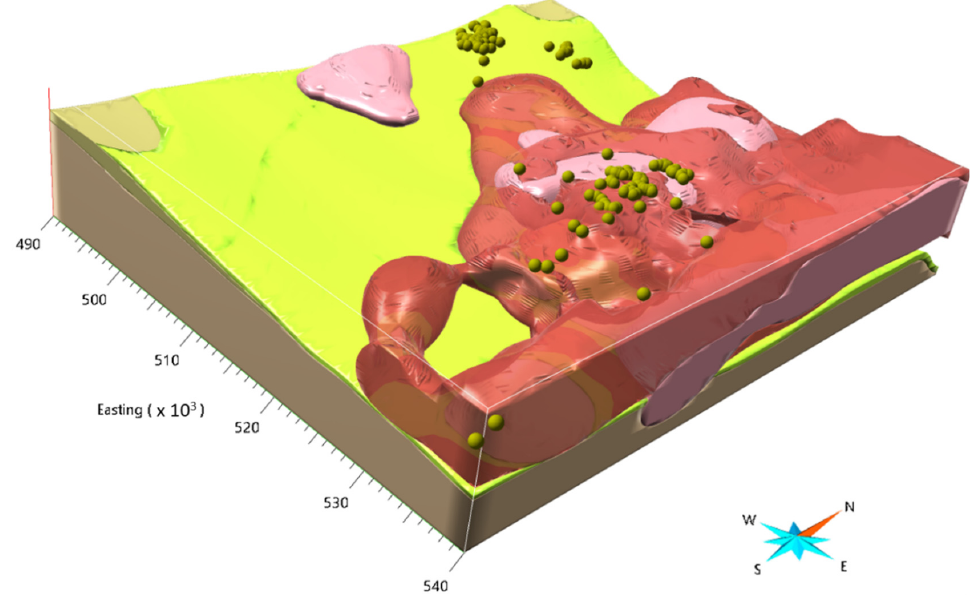
Figure 20. The Lebrina 3D model showing granite (pink) and granodiorite (salmon) volumes intruding ultramafic (light green) and basement (tan) lithologies. Note gold occurrences (gold spheres) proximal to granitic cupolas.